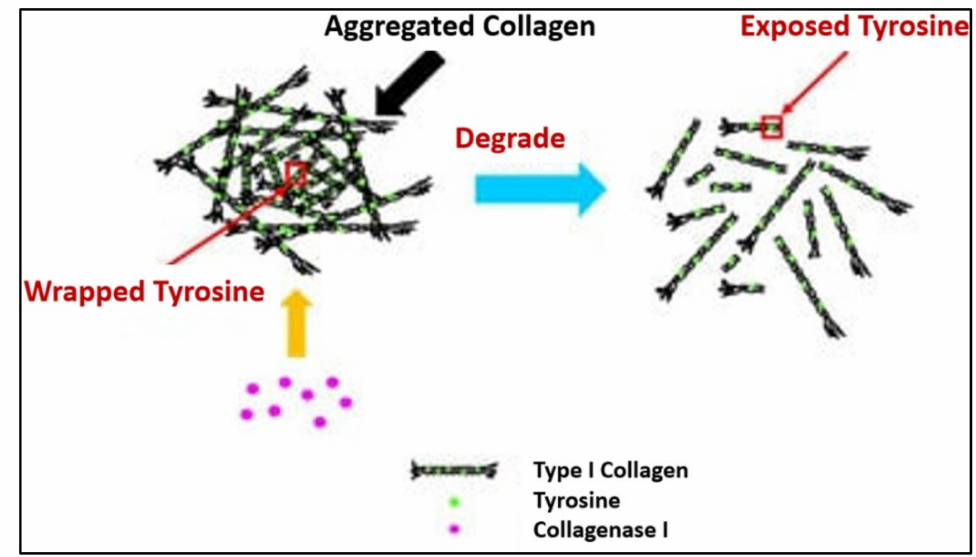
Figure 14. Process of collagen breakdown with the presence of a physiologic collagenase en- zyme [100].